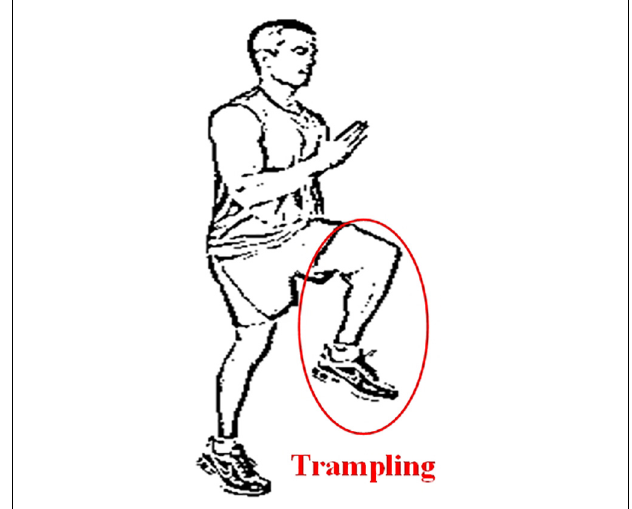
FIGURE 3 | Sensory ataxia Gait.